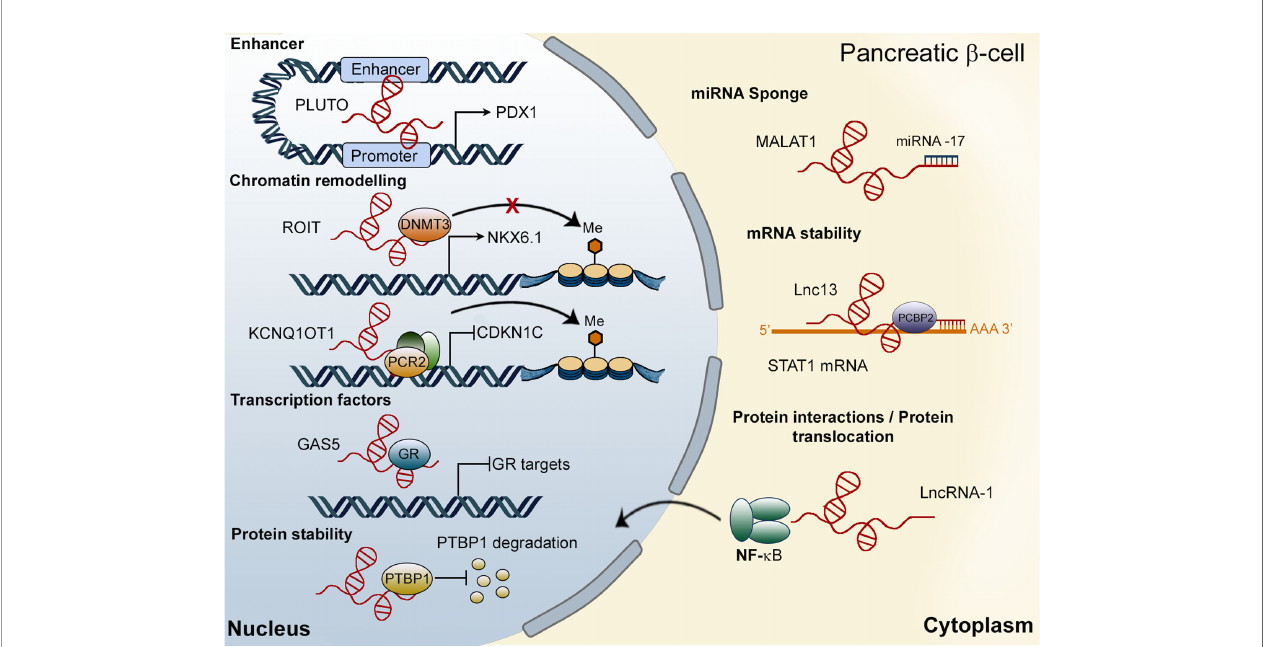
FIGURE 2 | Mechanisms of action of lncRNAs in pancreatic b -cells. In the nucleus, lncRNAs, such as PLUTO, regulate the transcription of target genes (PDX1) by modulating enhancer/promoter interactions. Other LncRNAs, including ROIT and KCNQ1OT1, interact with chromatin remodeling proteins. The lncRNA GAS5 has been shown to act as a decoy for the glucocorticoid receptor (GR), inhibiting the expression of GR target genes. Finally, MALAT1 has been found to be located in the nucleus (regulating PTBP1 protein stability) as well as in the cytoplasm of b -cells, where it interacts with miRNA-17. Cytosolic lncRNAs can also modulate mRNA stability or affect protein-protein interactions or their subcellular